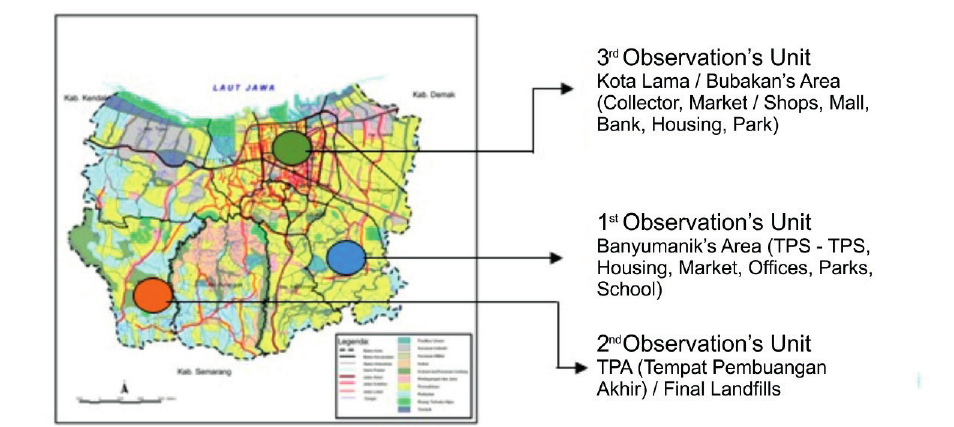
Fig. 2. 1 st , 2 nd , 3 rd Observation